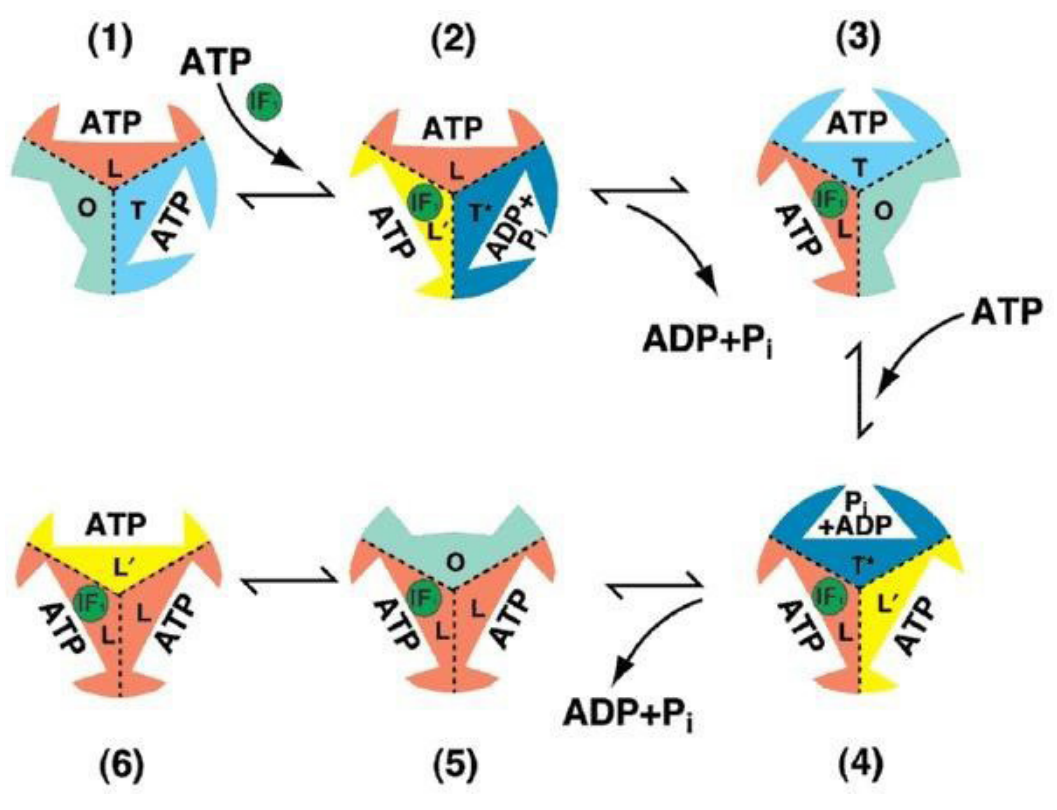
This scheme is based on the binding change mechanism of ATP hydrolysis [36]. Figure 5: The inhibition of the ATP hydrolytic activity of ATP synthase by IF1. IF1 is a naturally occurring 9.6 kDa basic protein that comprises of 84 amino acids and is known to inhibit the hydrolytic activity of mitochondrial ATP synthase [37]. It acts by binding to ATP synthase at the F domain in the COOH-terminal region of the β-subunit in an area which is in contact with the central γ subunit. It disrupts the contact 1 between the β and γ subunits, thereby inhibiting the function of ATPase